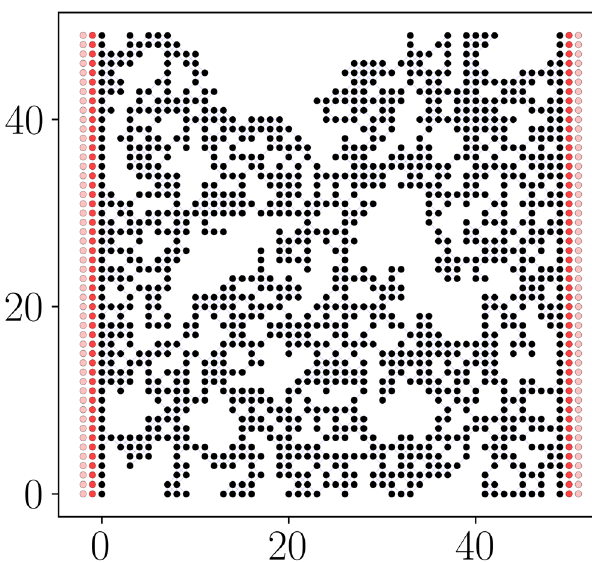
Fig. 7 Transport setup. Here we see a random snapshot of a 50 × 50 system and its leads connectivity. In order to ensure the full lead- system connectivity, a row of lattice sites are appended at each